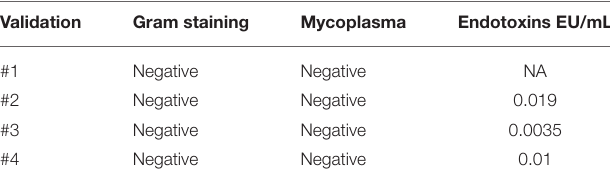
TABLE 5 | Results from sterility